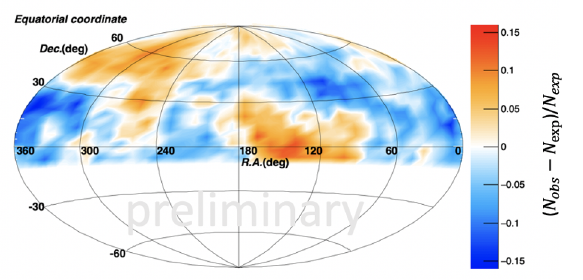
Figure 2. Energy distribution of TALE SD during two-years data (black plots) and the MC prediction using proton of QGSJetII-04 model under the assumption of isotropic distribution (red his- togram)